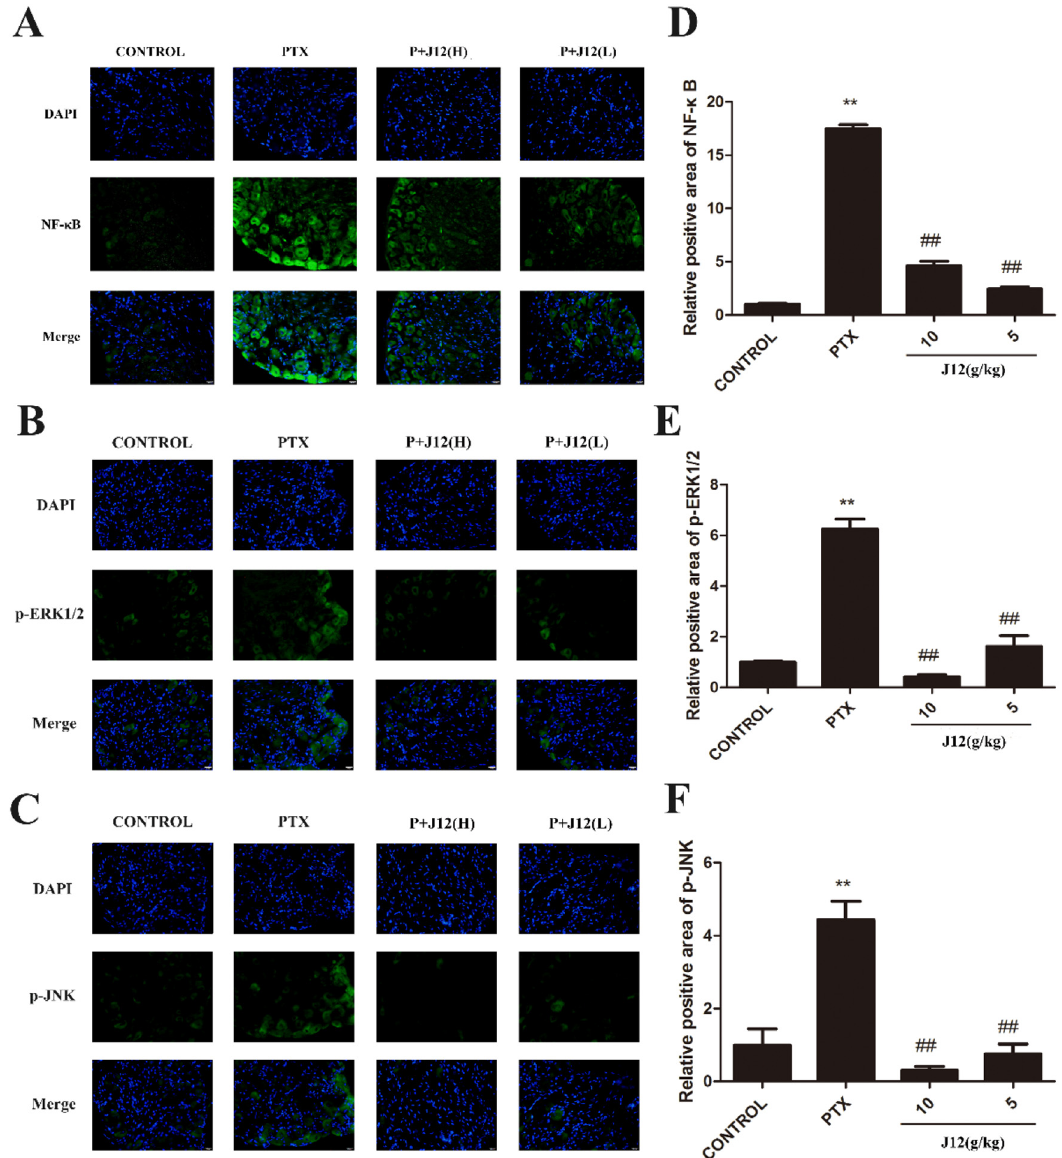
Fig. 3. Immunostaining analysis of NF- k B, p-ERK1/2 and p-JNK in DRG neurons. (A – C) The expressions of NF- k B, p-ERK1/2 and p-JNK were increased after PTX treatment and J12 inhibited the expressions. (D) Quanti fi cation of NF- k B immuno fl uorescence intensity in the DRGs. (E) Quanti fi cation of p-ERK1/2 immuno fl uorescence intensity in the DRGs. (F) Quanti fi cation of p-JNK immuno fl uorescence intensity in the DRGs. n = 5 in each group. Magni fi cation (cid:1) 400. **vs Control, p < 0.01; ## vs PTX, p < 0.01. Data are expressed as mean ±